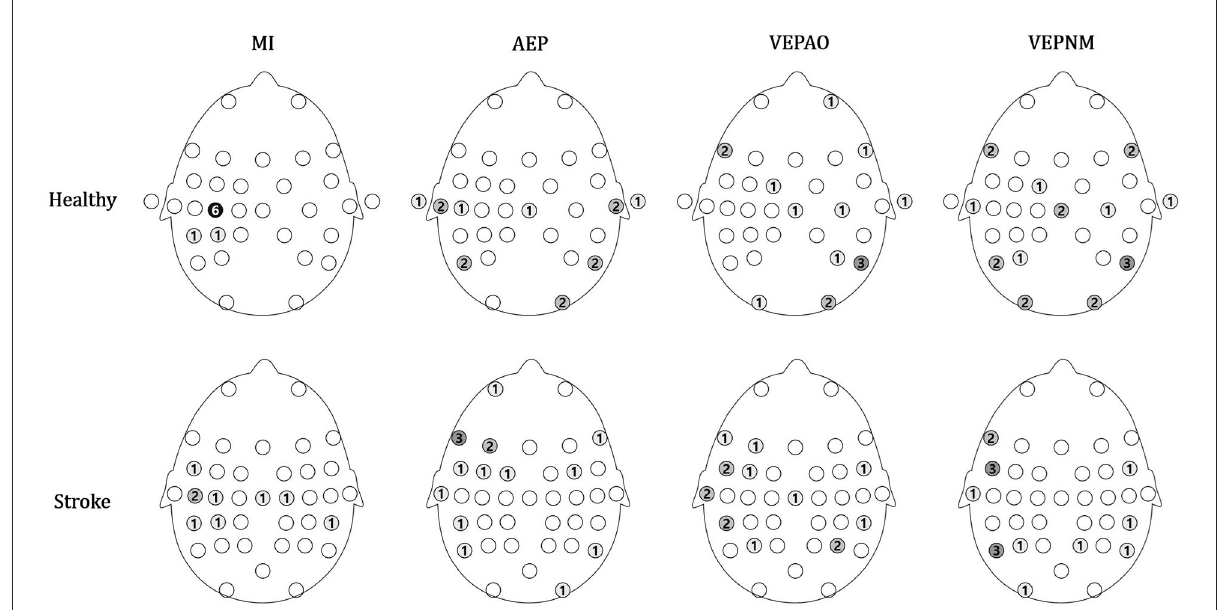
FIGURE8 Group analysis of the topographical map for the number of regions of interest (ROI) and non-ROI candidate channels. The number of ROI channels is shown in blue, and the number of non-ROI candidate channels is shown in red. VEPAO, VEP with action observation; VEPNM, non–motor-related